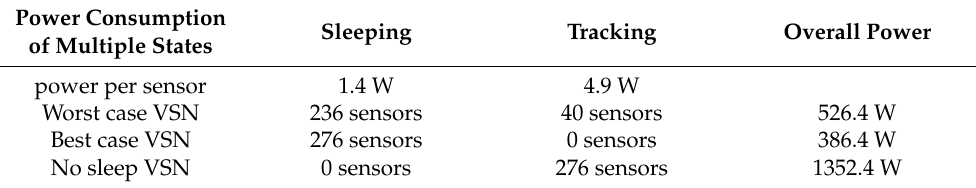
Table 6. Comparison of power consumption between the worst and the best case for the entire system. Power Consumption Sleeping Tracking Overall Power of Multiple States power per sensor 1.4 W 4.9 W Worst case VSN 236 sensors 40 sensors 526.4 W Best case VSN 276 sensors 0 sensors 386.4 W No sleep VSN 0 sensors 276 sensors 1352.4